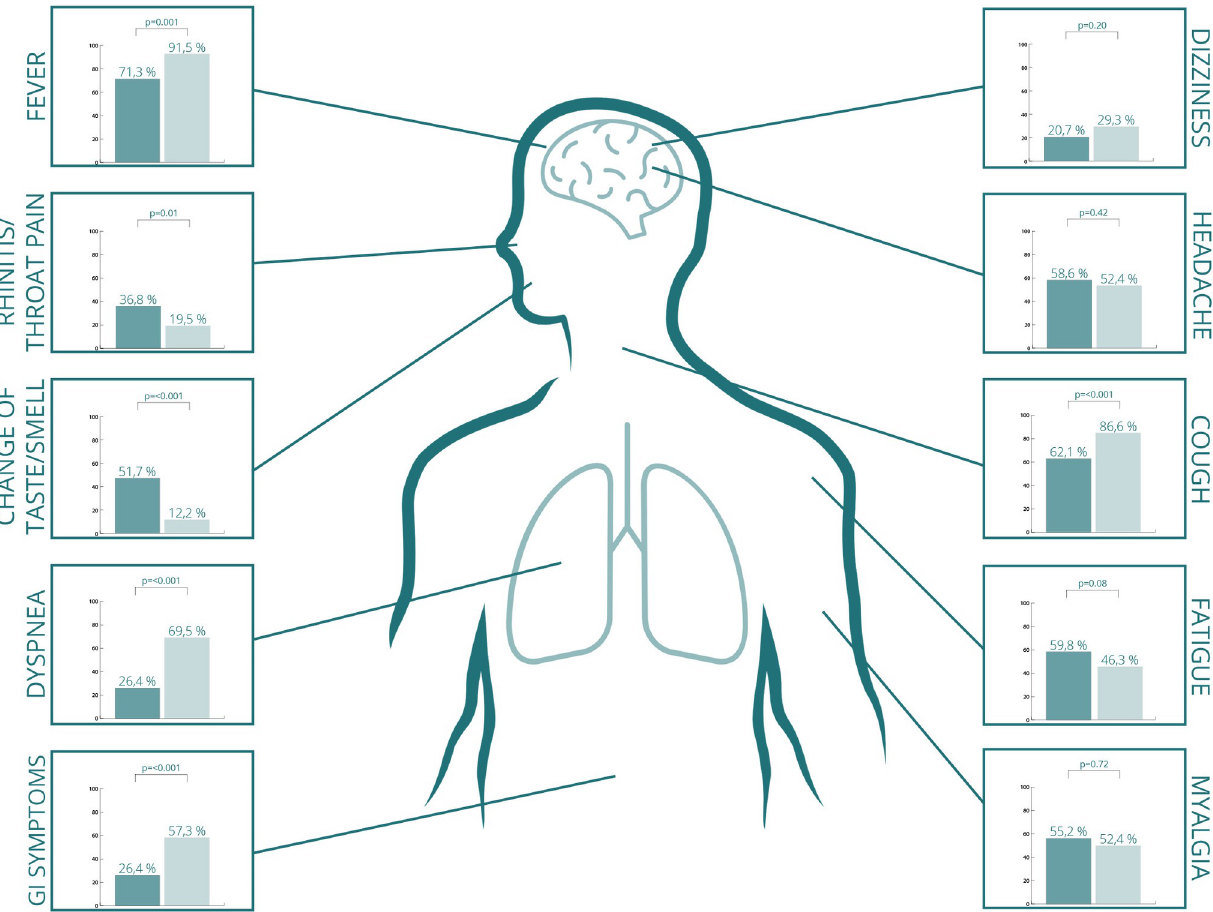
Fig 2. Number of patients displaying different symptoms among a non-hospitalised cohort (n = 87, displayed in dark green), and a hospitalised cohort (n = 82, displayed in light green) of adult COVID-19 patients. https://doi.org/10.1371/journal.pone.0258421.g002 sputum samples (26 inpatients), with median C -values of 25.5 (IQR 22.3–28.8) and 24.4 (IQR q 19.8–32.7), respectively (p = 0.61). Among the 165 patients with known symptom onset, we